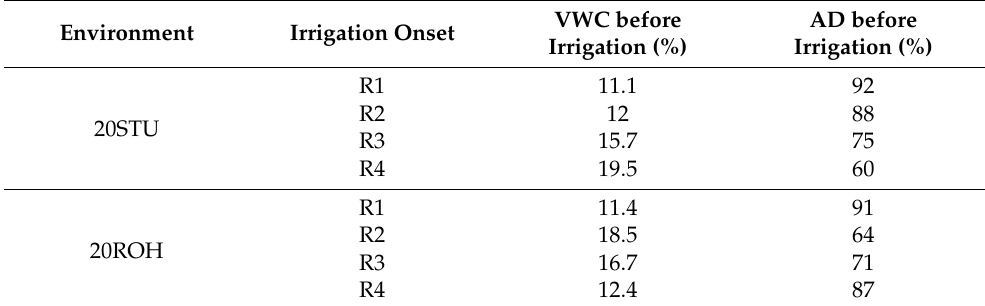
Table 2. Average percent of soil volume water content (VWC) and allowable depletion (AD) before irrigation from different irrigation onsets in two environments 20STU and